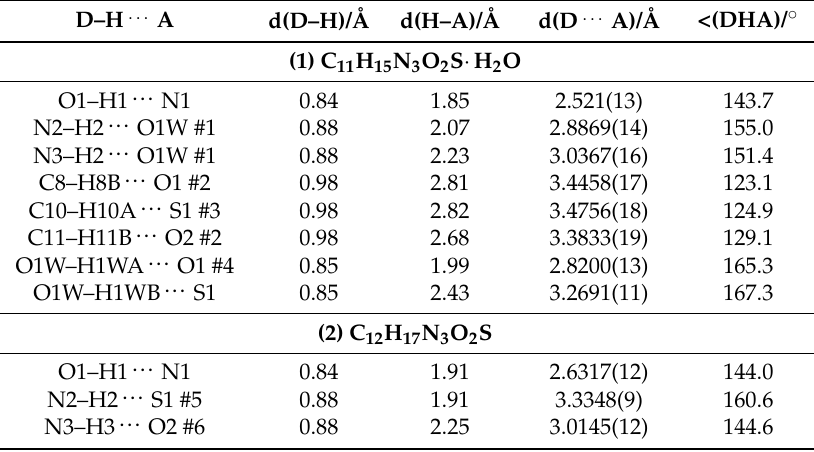
Table 2. Hydrogen bond interactions for ( 1 ) and ( 2 ) (Å and ˝